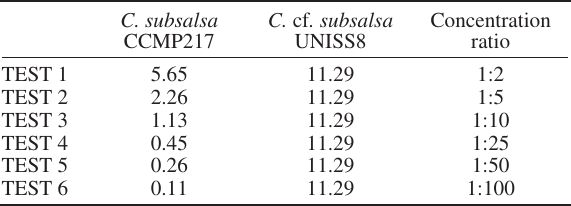
Table 3. – List of tests carried out using the two C. subsalsa geno- types with different DNA concentrations (ng µL –1